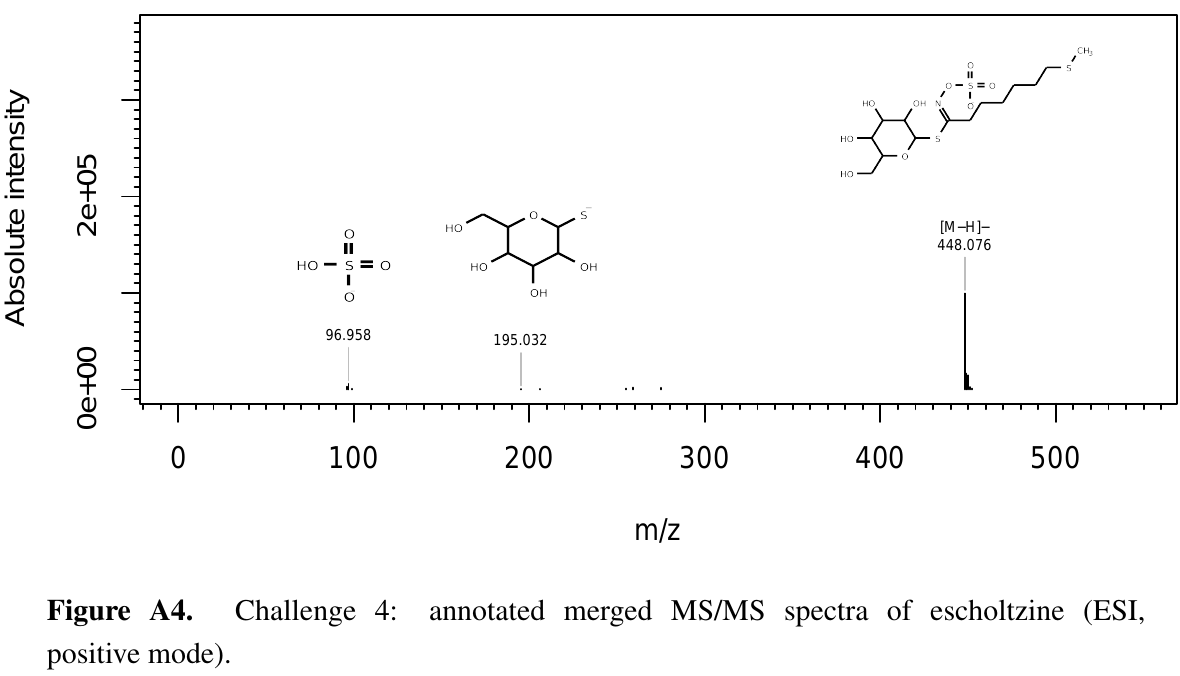
Figure A3. Challenge 3: annotated merged MS/MS spectra of glucolesquerellin (ESI, negative mode).